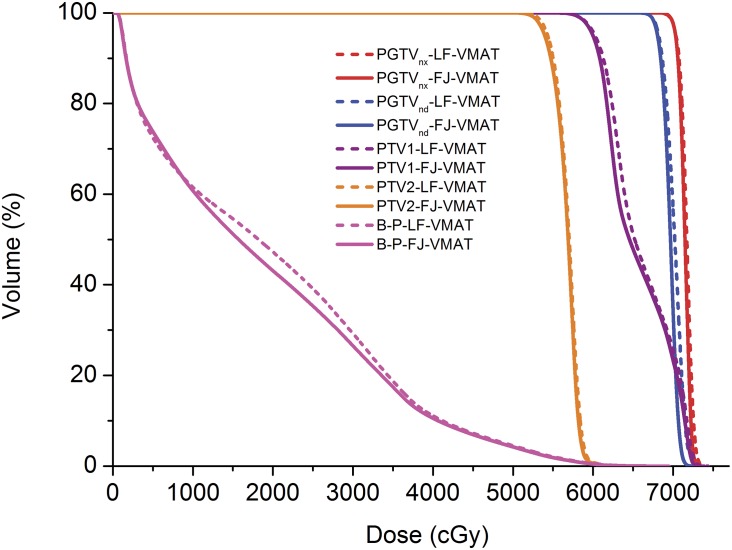
Dose-volume histograms (DVHs) of the large-field volumetric arc therapy (LF-VMAT) and fixed-jaw VMAT (FJ-VMAT) plans.The solid line: the FJ-VMAT plans. The dotted line: the LF-VMAT plans.